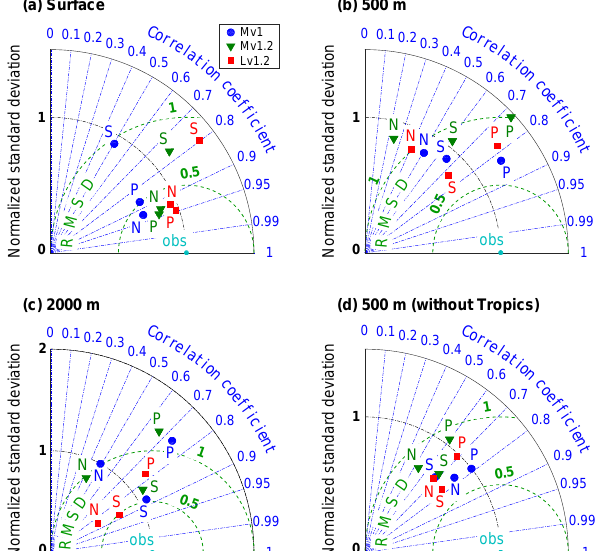
Figure 15. Taylor diagrams for phosphate (P), nitrate (N), and sili- cate (S) for model configurations Mv1 (blue circles), Mv1.2 (green triangles), and Lv1.2 (red squares) at (a) surface, (b) 500m depth, and (c) 2000m depth. Panel (d) shows results for the 500m depth level, with error-prone grid points located in the tropics (between 20 ◦ N and 20 ◦ S) omitted from the analysis. Observations are the objectively analysed climatologies from WOA 2009 (Garcia et al., 2010b). Model fields have been averaged over the time period dur- ing which the bulk of observations in WOA 2009 were acquired (1965 to